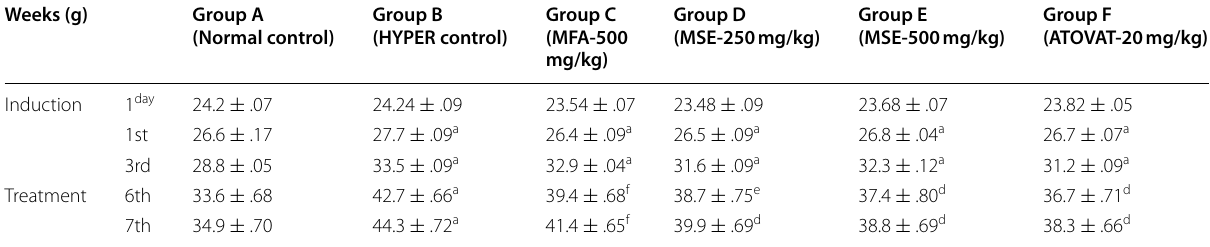
Table 3 The propensity of body weight during treatment with different MM extracts in hyperlipidemic mice Weeks